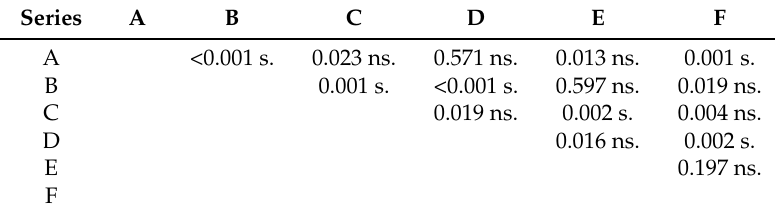
Table 7. Statistical test results: p ‐ values of the U ‐ test with Bonferroni correction ( α = 0.003) of the surface roughness Sz between the series after the end of the test; s. = significant; ns. = not significant.